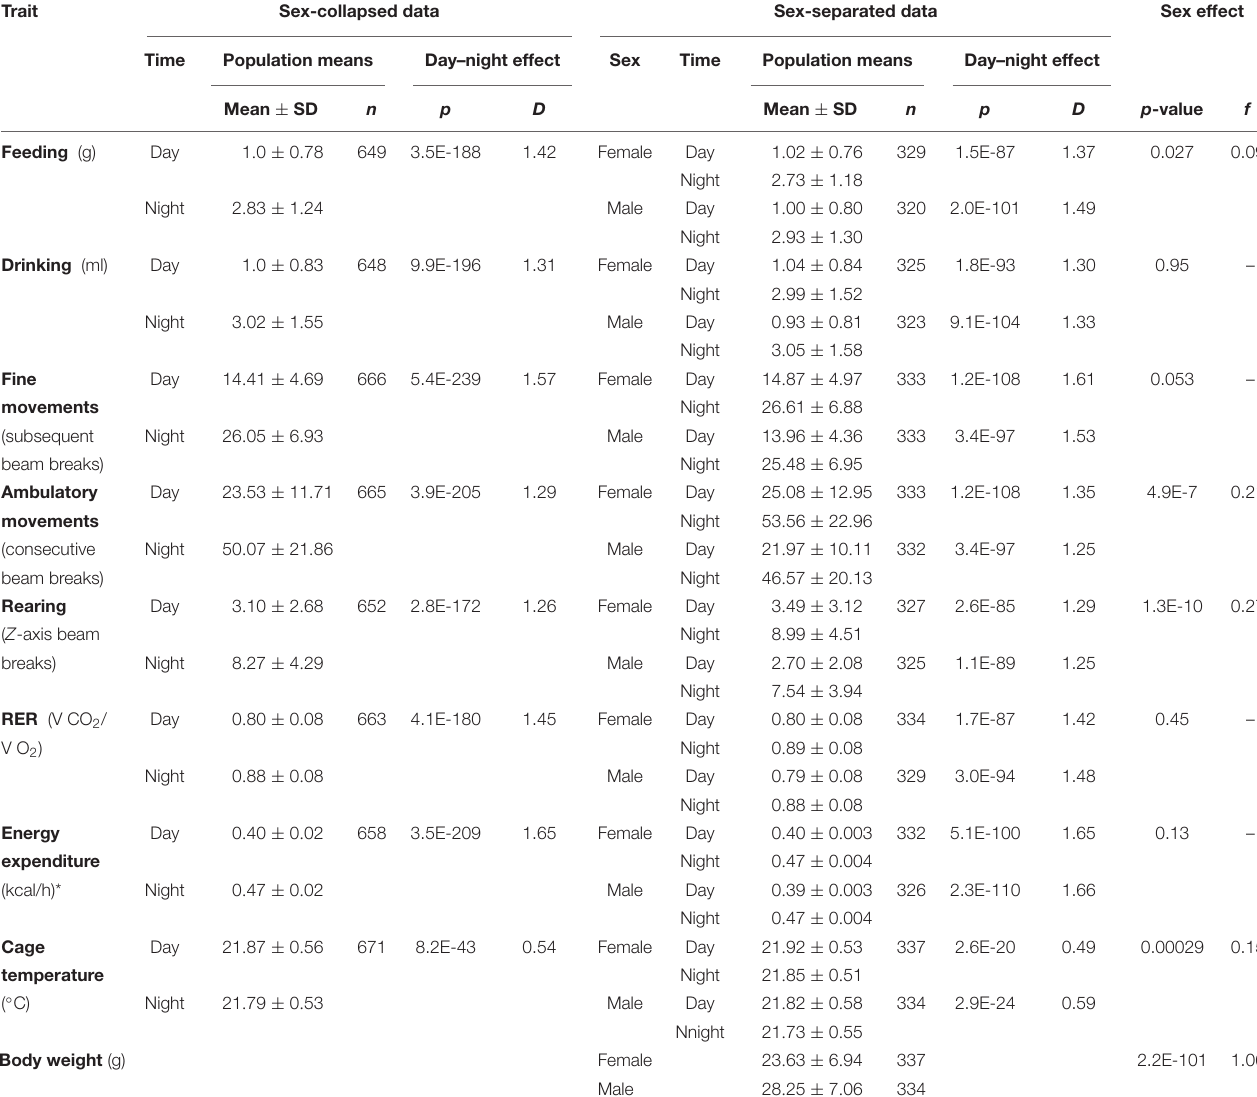
TABLE 3 | Influence of day–night variation and sex on the behavioral traits. Trait Sex-collapsed data Sex-separated data Sex